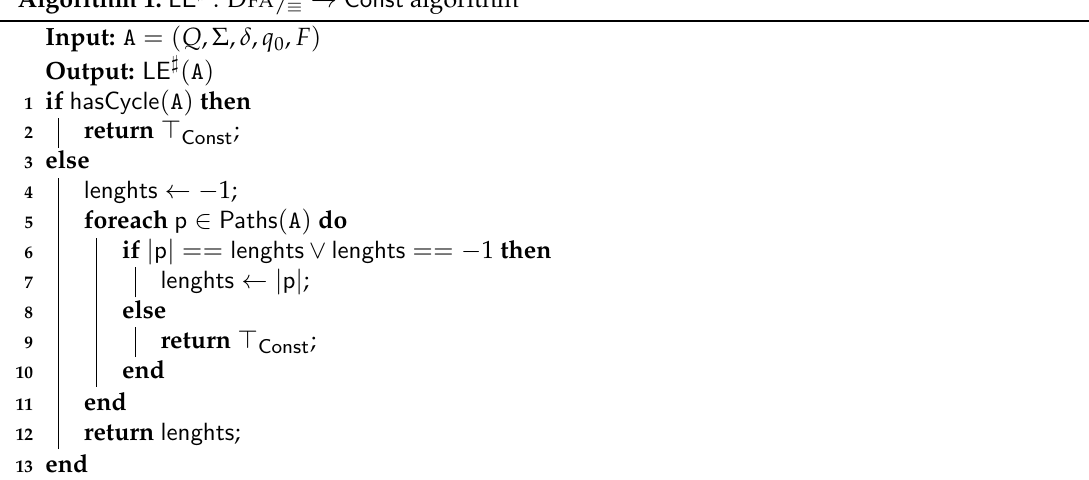
Algorithm 1: LE (cid:93) : D FA / ≡ → Const algorithm Input: A = ( Q , Σ , δ , q 0 , F